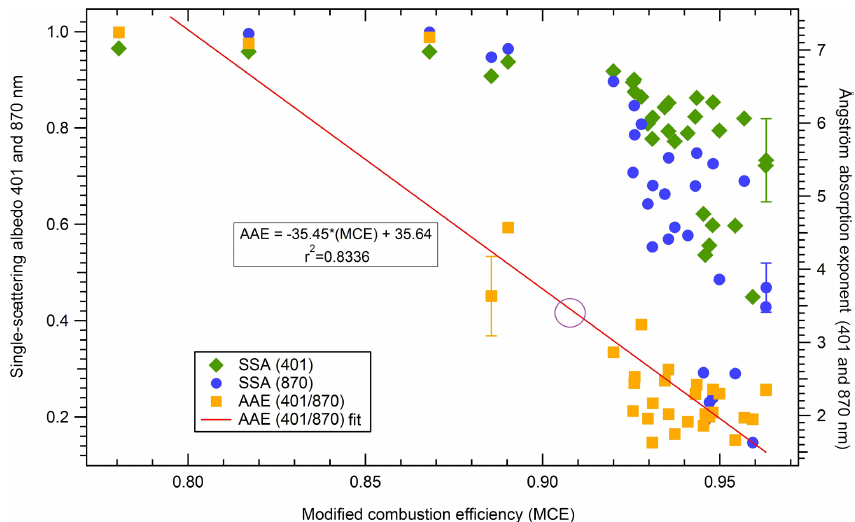
Figure 7. SSA at both wavelengths (401 and 870nm) and AAE (401 and 870nm) against MCE for 31 stack fires for which both 401 and 870nm data were available. The circle on the fit line represents the lab-predicted AAE using the wildfire field-average MCE of 0.912. SSA is difficult to fit to MCE and fits better to EC and OC data, which were not available (Liu et al., 2014; Pokhrel et al., 2016).